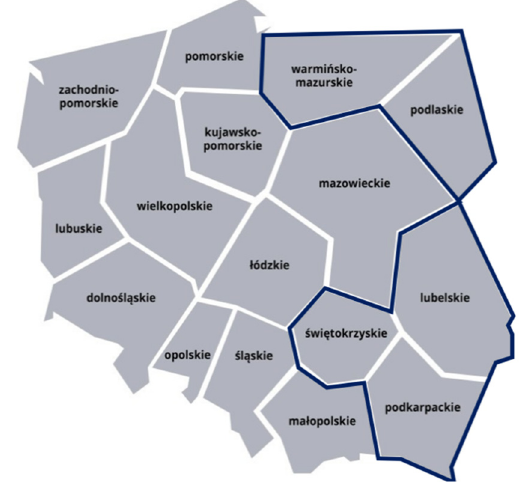
Figure 2. Eastern Poland macroregion.